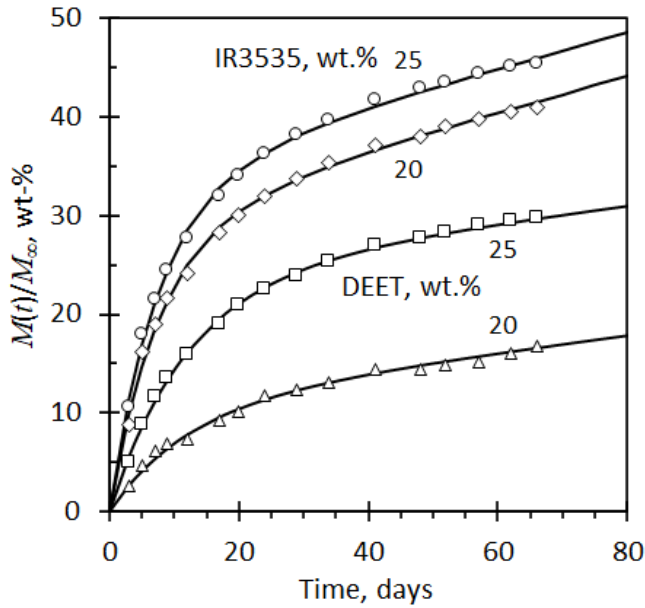
Figure 7. Repellent release data for DEET and IR3535 trapped inside cylindrical PLA strands. The initial concentrations of the repellents are indicated. The data reflects measured mass loss data recorded on ageing blends in convention oven controlled at 50 ◦ C over a period of 66 days. The solid lines represent prediction data obtained by Equation (3) based on the regression constants presented in Table